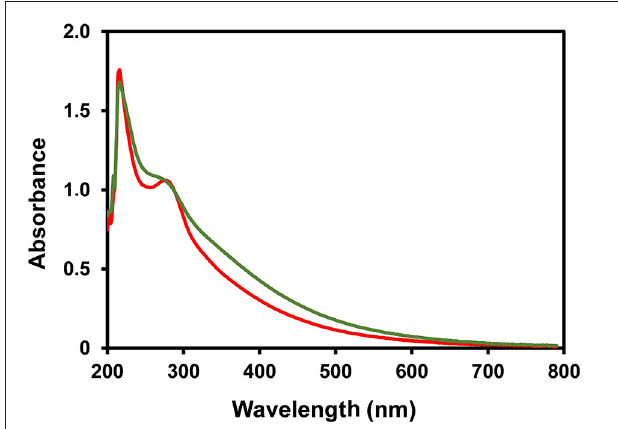
FIGURE 1 | UV-Visible spectra of EtSn ISC melanoidin population (green line) and of ISB melanoidin population (red